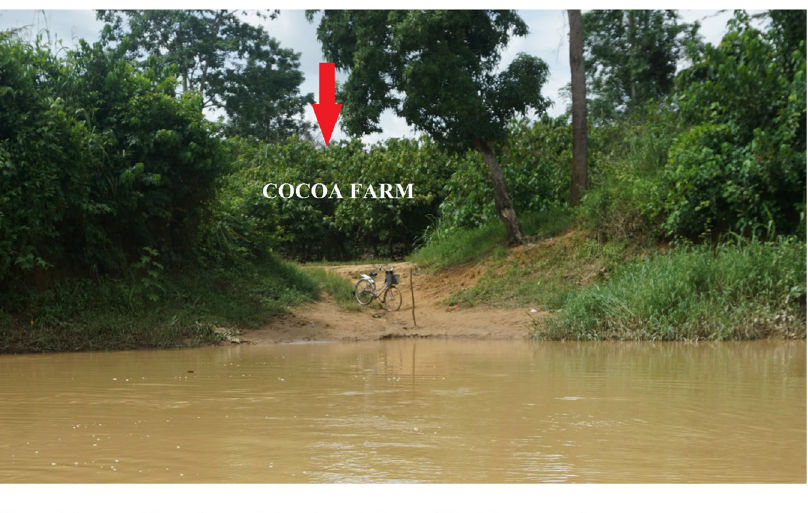
Figure 7. Cocoa farm near river Birim at Abomosu